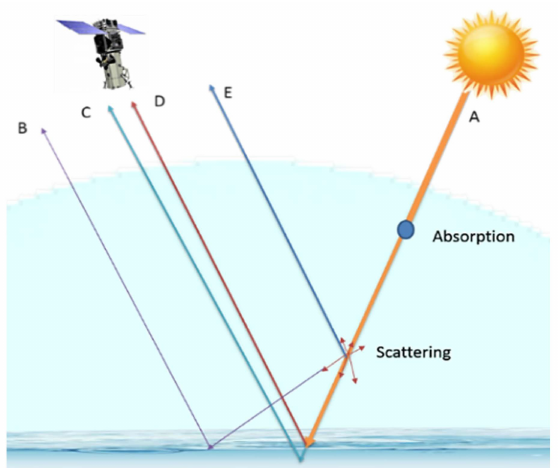
Figure 4. Simplified schematic diagram showing routes by which light reaches a remote sensing